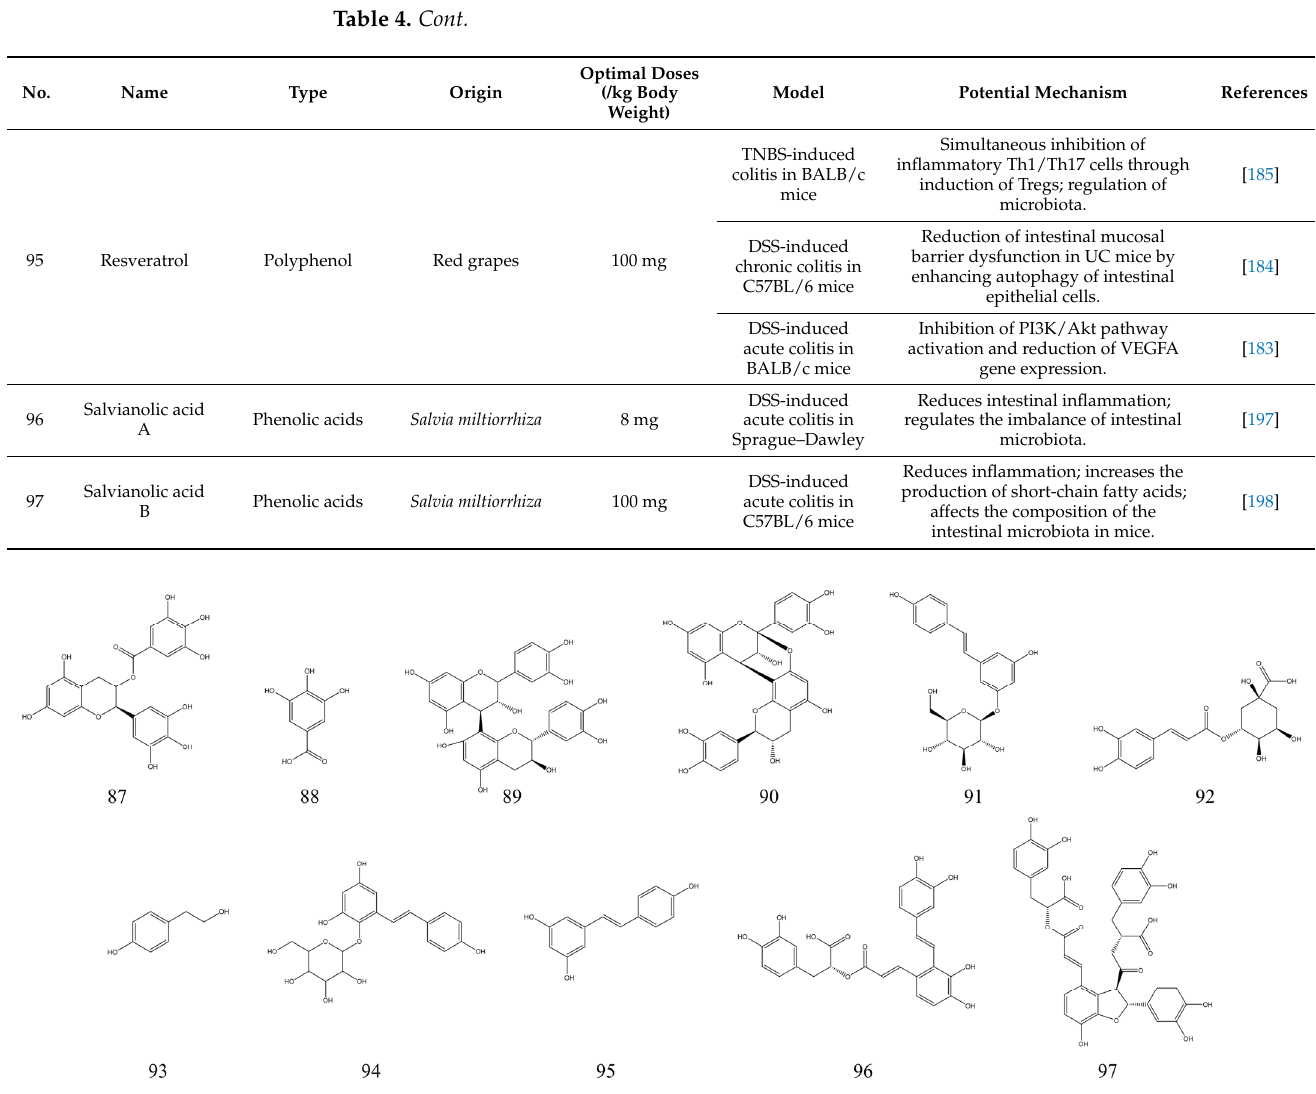
Figure 7. Structural formulae of polyphenolic compounds with IBD therapeutic effects. Table 4. In vivo therapeutic effects of polyphenolic compounds on experimental IBD.